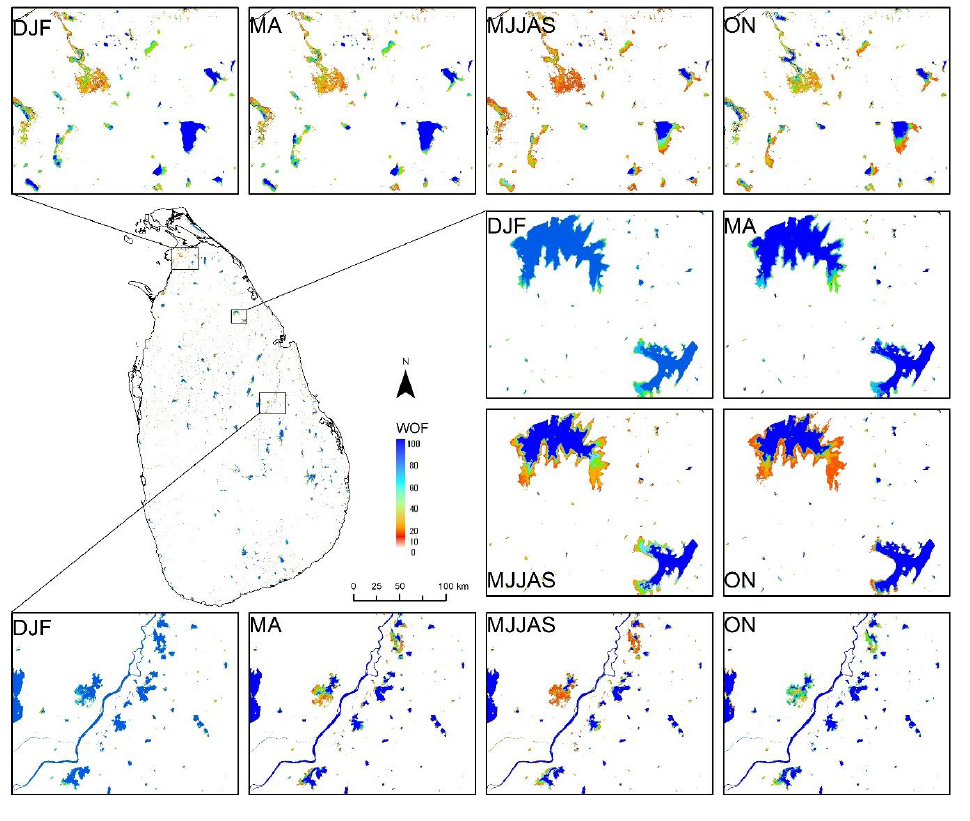
Figure 6. Intra-annual water occurrence frequencies (WOF) in Sri Lanka for the whole time-series (1988–2019).